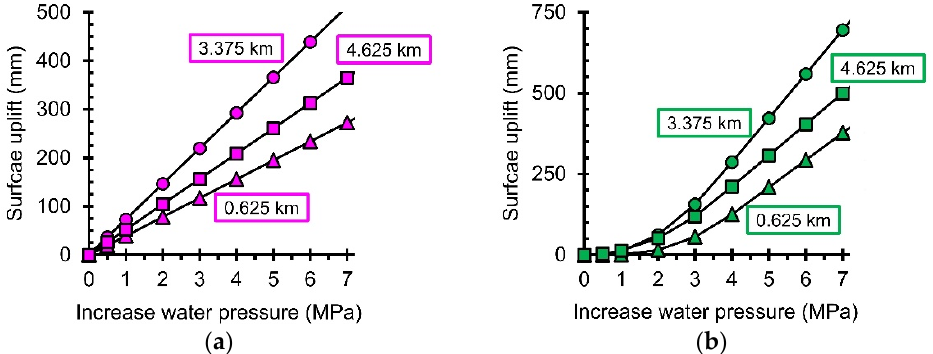
Figure 8. Variation of the amount of uplift as a function of the increase in water pressure: ( a ) The original framework developed in [17]; ( b ) The model assuming an open reservoir. Information is presented for three north–south coordinates: triangles presenting the coordinate of 0.625 km, circles 3.375 km and squares 4.625 km.